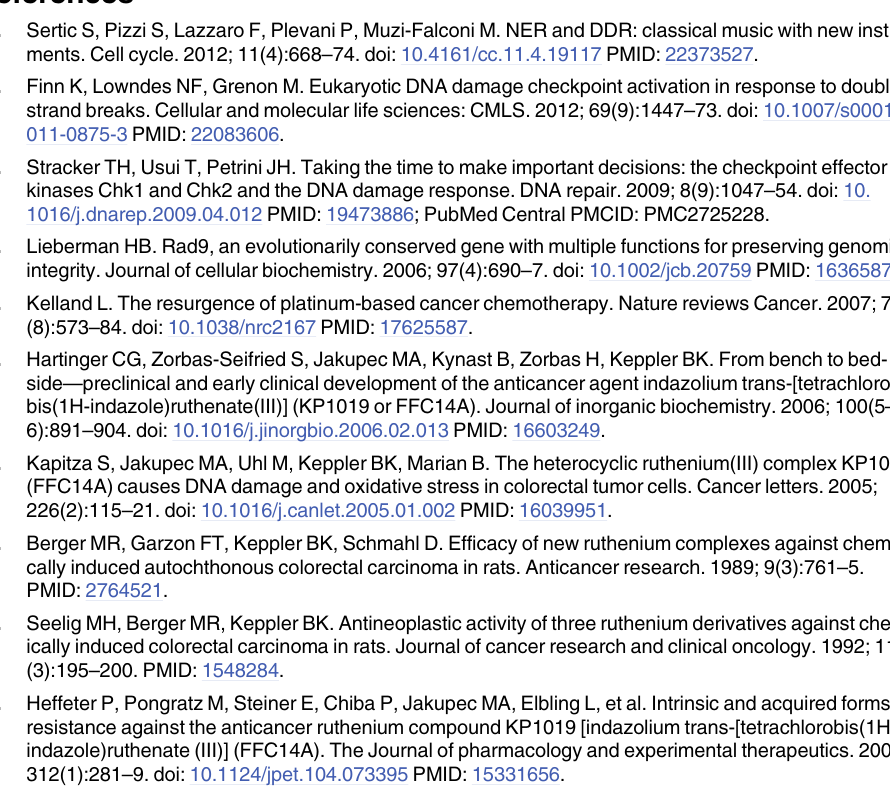
S1 Fig. Orientation of spindle relative to longitudinal axis of cell. Box plot represents the upper quartile where 25% of the data is greater than this value and the lower quartile where 25% of the data is less than this value. Whiskers show largest and smallest angle values, not including outliers. Outliers are either more or less than 3/2 times the upper or lower quartile (respectively). Line internal to the box indicates the median angle. Treatment with drug results in a broader distribution of angles as compared to the untreated samples.